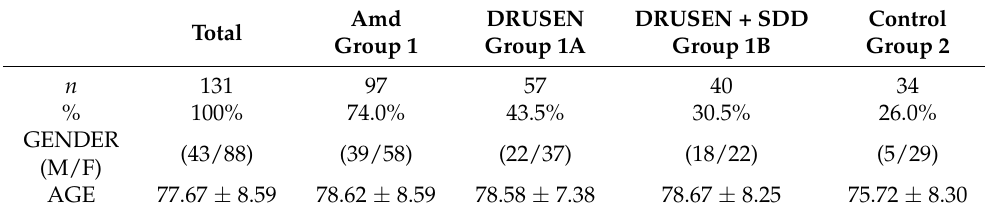
Table 1. Demographic characteristics of study